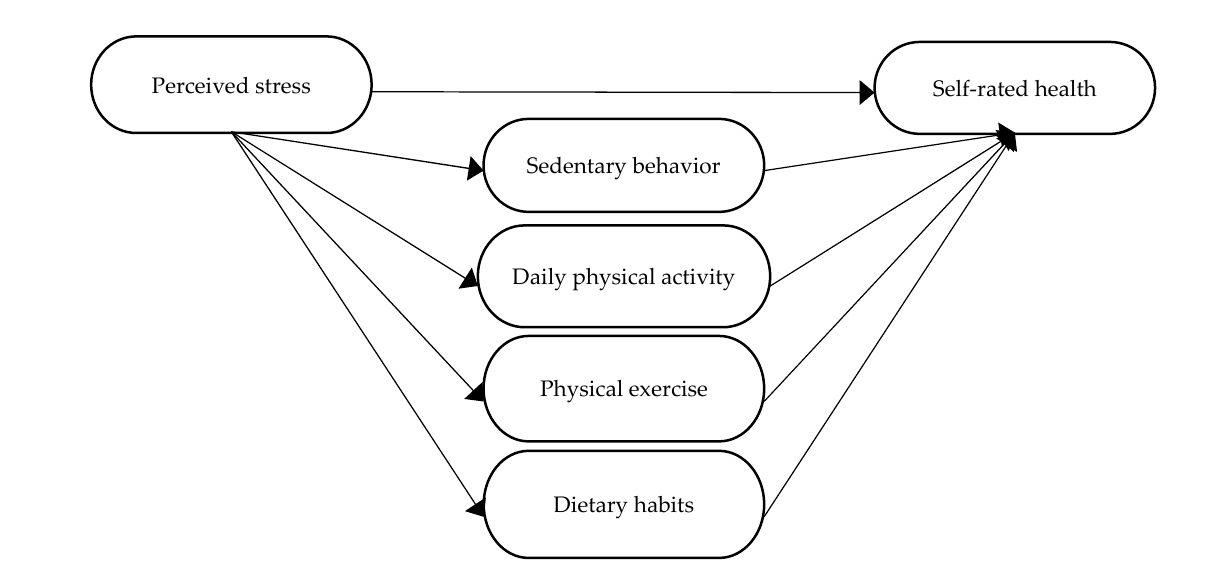
Figure 1. The hypothesized mediation model with four parallel mediators.